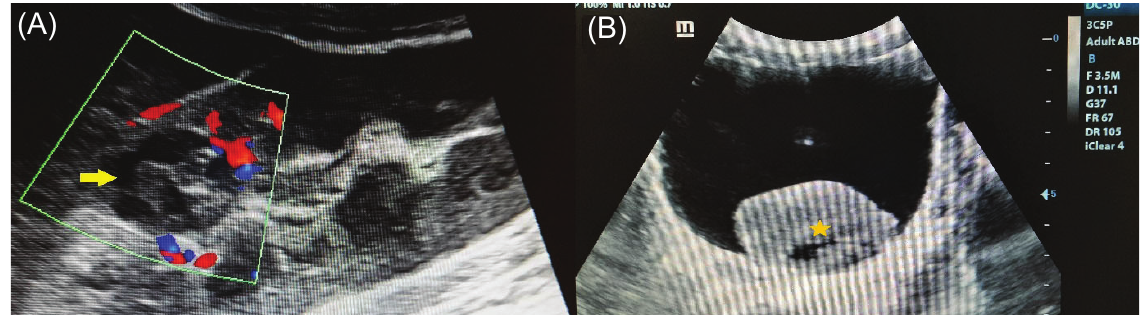
Figure 1: Color Doppler ultrasonography image demonstrating no significant vascularity within the well-circumscribed hetero- echoic cortical based lesion (arrow) in the upper pole of right kidney. (A) High-resolution transverse ultrasonography image demonstrating a giant retained clot (star) within the lumen of the urinary bladder secondary to symptomatic hematuria